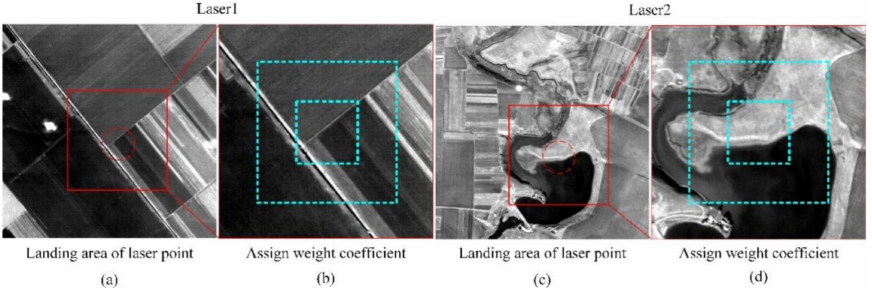
Figure 4. Diagrams of refined cloud detection.